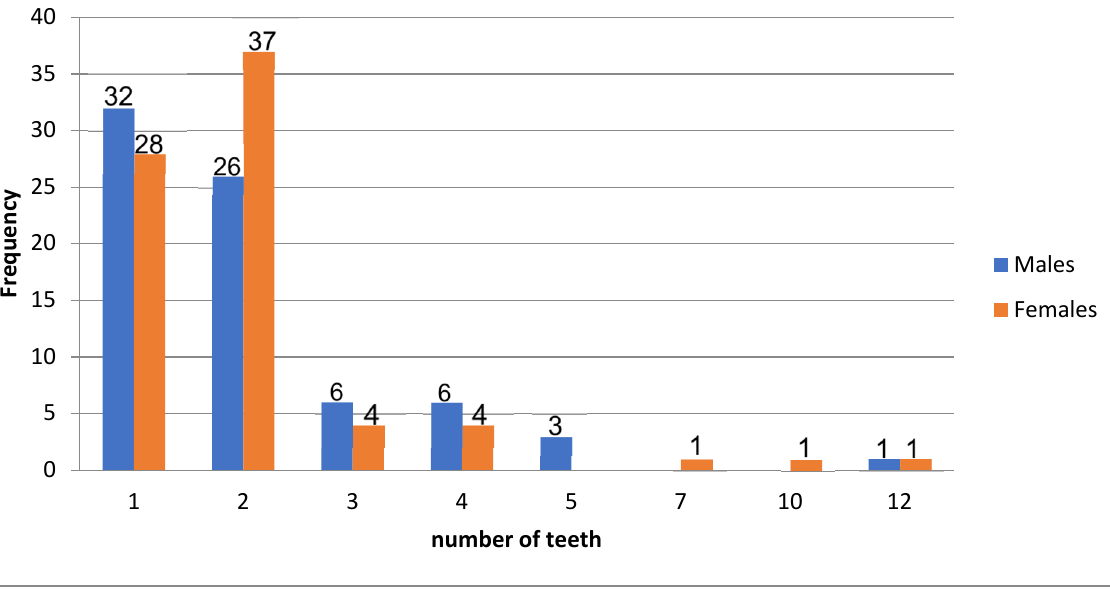
Table 3. The prevalence of dental anomalies by consanguinity groups.